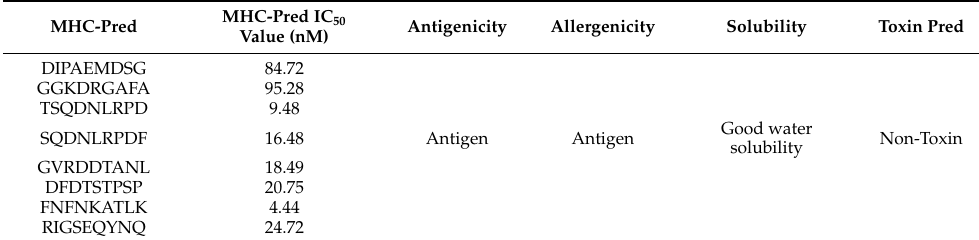
Table 8. After analysis of MHC-Pred, antigenicity, allergenicity, solubility, and toxin-pred, the following epitopes are shortlisted.